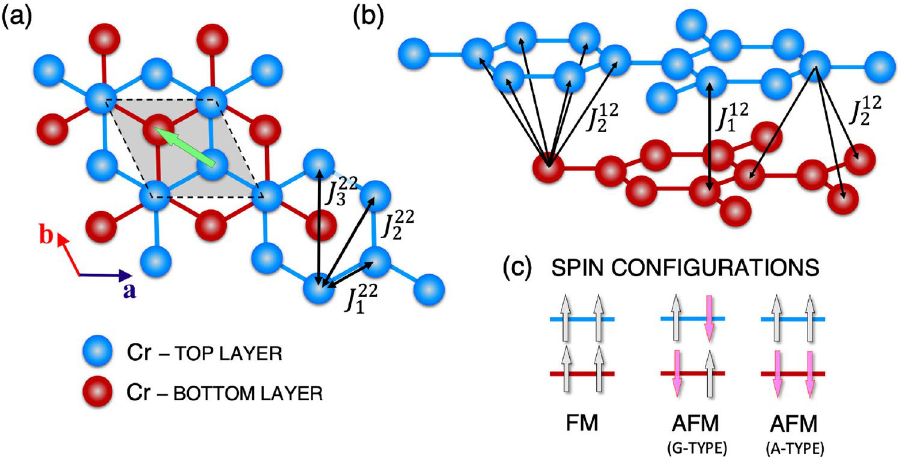
Figure 1. (Color online) ( a , b ) Arrangement of Cr atoms in the lattice of the CrCl 3 bilayer in the LT phase. The inter- and intralayer magnetic interactions between Cr atoms are indicated. The green arrow indicates the direction of lateral shift between the top and bottom layers. ( c ) Schematic plot of three different spin configurations of bilayer CrCl 3